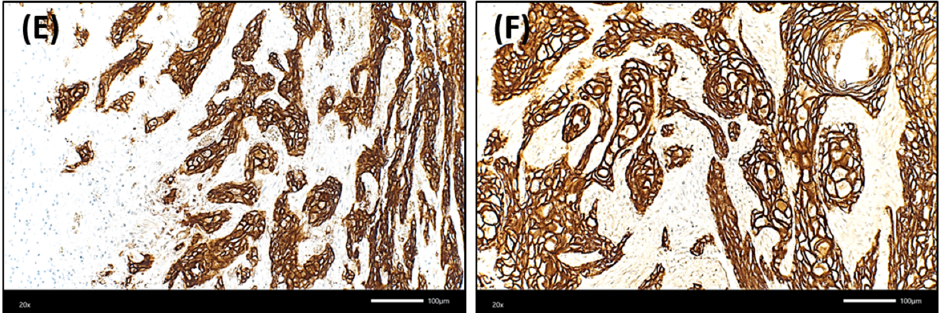
Figure 1. Membranous staining of Trop-2 in oral squamous cell carcinoma (OSCC) using immuno- histochemistry (Trop-2 immunohistochemistry, × 200 magnification). OSCC cases presented with membranous Trop-2 expression; however, the intensity and percentage of positively stained cancer